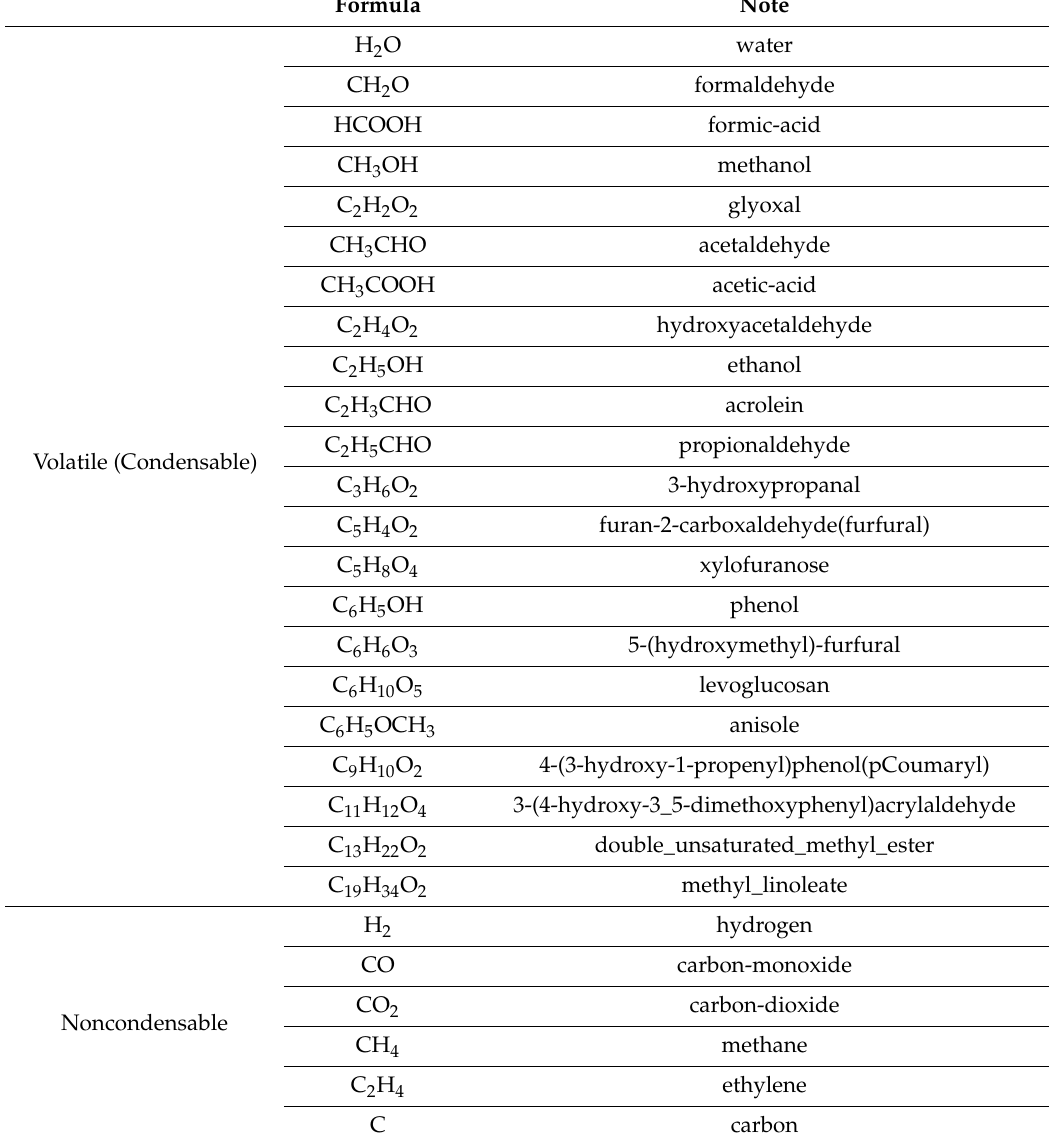
Table 5. Gaseous species in the simulation